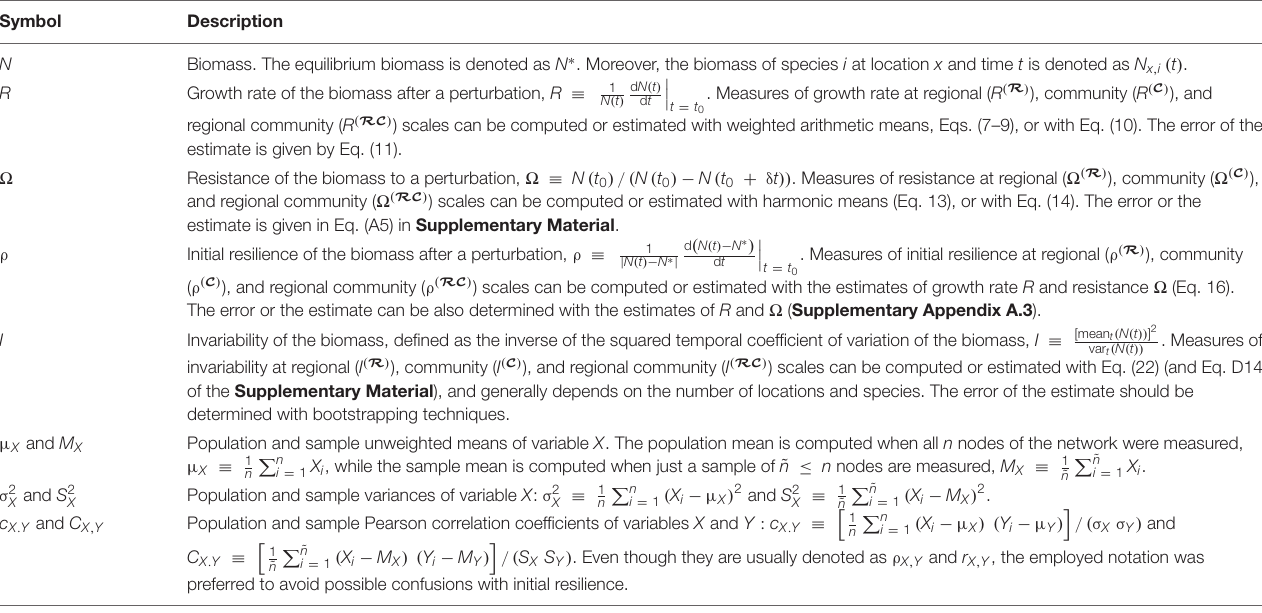
FIGURE 2 | Regional (A) and community (B) growth rates, compared to local and species growth rates and to their unweighted arithmetic mean (AM) (yellow circles), and biomass weighted arithmetic mean (AM w ) (green circles). AM and AM w values closer to the identity line (black, dashed) estimate more precisely the regional (A) and community growth rate (B) . Black dots are the growth rates of individual localities (A) or species (B) on which the means AM and AM w were computed. Data were generated for 6,300 random communities of 10 competitors in 10-node random spatial networks ( Supplementary Figure 1A and Supplementary Text ), after a biomass decrease from the equilibrium affecting all species at all locations. AM w are found to be better estimators of the growth rate, as expected from the results shown in the text. TABLE 1 | Summary table: symbols used in the article and their descriptions. Symbol